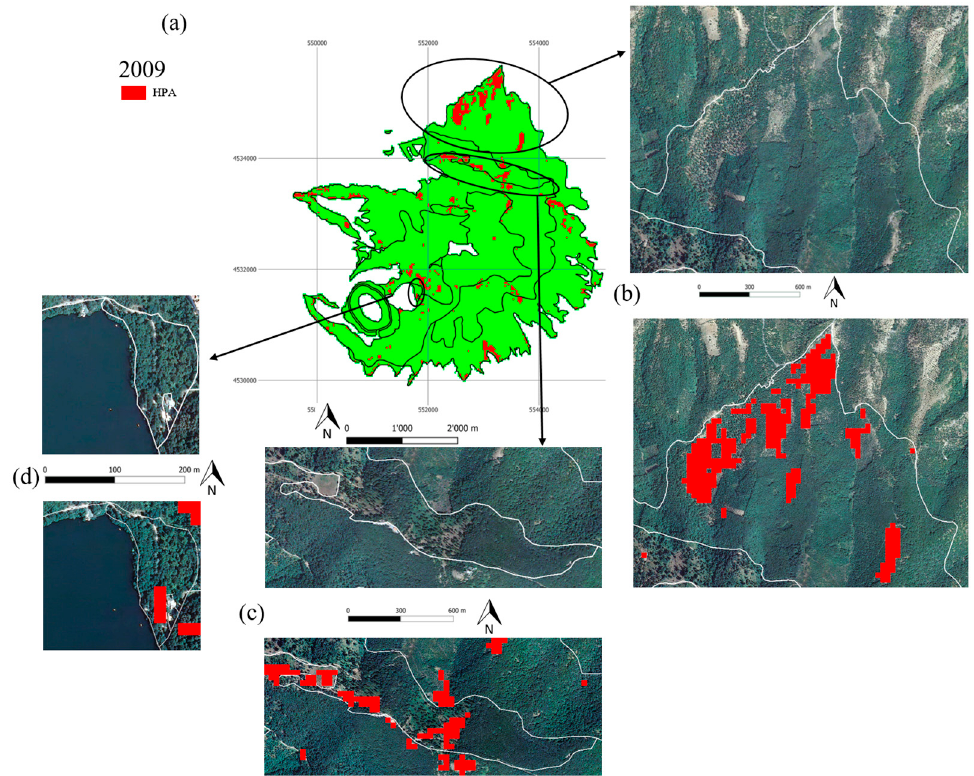
Figure 5. Monte Vulture SAC: ( a ) Maps of relative anomalies (2009); zoom of negative anomalies superimposed on the orthophoto within ( b ) habitat 9260 ( Castanea sativa woods ) due to abandonment of marginal areas and bad management of forest areas; ( c ) habitat 9510* ( Southern Apennine Abies alba forests ) due to grazing pressure and unfavorable biotope conditions; ( d ) habitat 91B0 ( Thermophilous Fraxinus angustifolia woods) due to tourism flows favoring the growth of synanthropic and alien species.